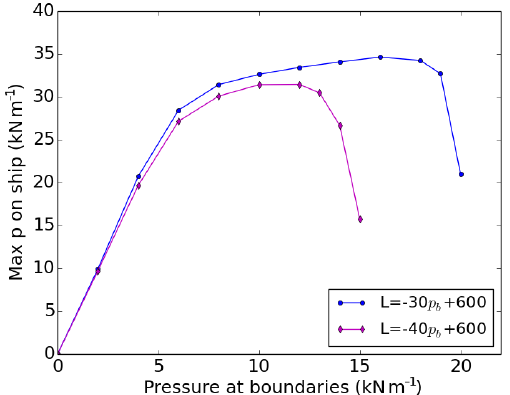
Figure 11. Maximum pressure (kNm − 1 ) on the ship as a func- tion of the pressure ( p b ) prescribed at the boundaries. For both curves, it is assumed that the length of the lead ( L ) is 600m for p b = 0kNm − 1 and that it decreases linearly as p b increases. For the blue, the lead behind the ship is closed when p b reaches 20kNm − 1 , while the lead is closed when p b = 15kNm − 1 for the magenta curve. The thickness field is 2m everywhere except in the lead be- hind the ship, where the thickness is 0m. The digitized ship is 90m long and 30m